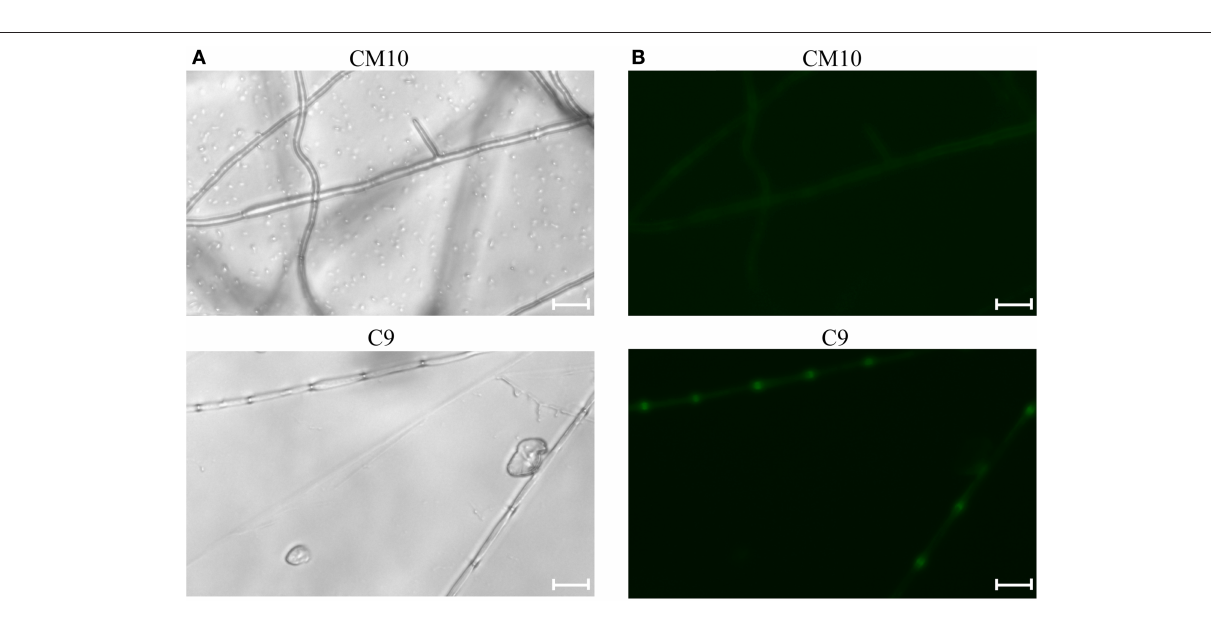
FIGURE 4 | Mycelia of the Cas9-GFP transformant C9 and negative control CM10 were shown under (A) bright field image and (B) fluorescence microscope (excitation, 395 to 440nm, and emission, 470nm). The bars were 20 µ